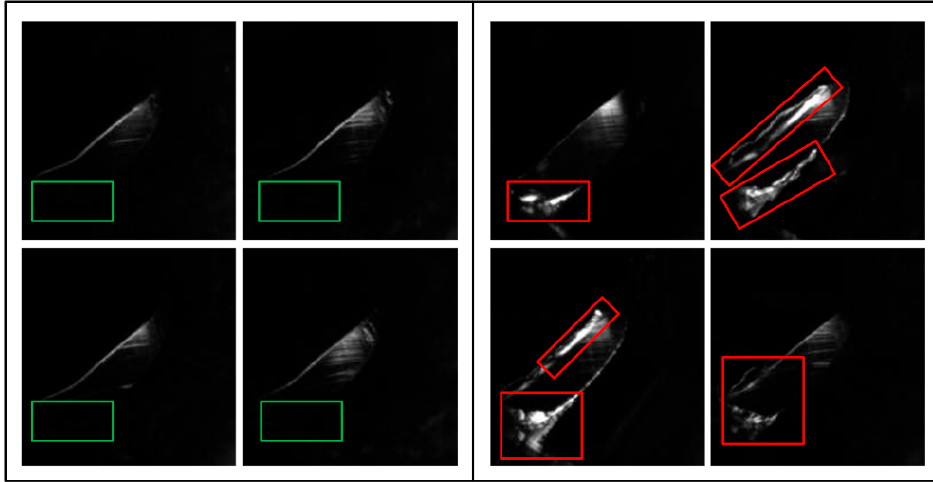
Figure 11. Cropped OK image ( left ) and NG defect ( right ) training images.